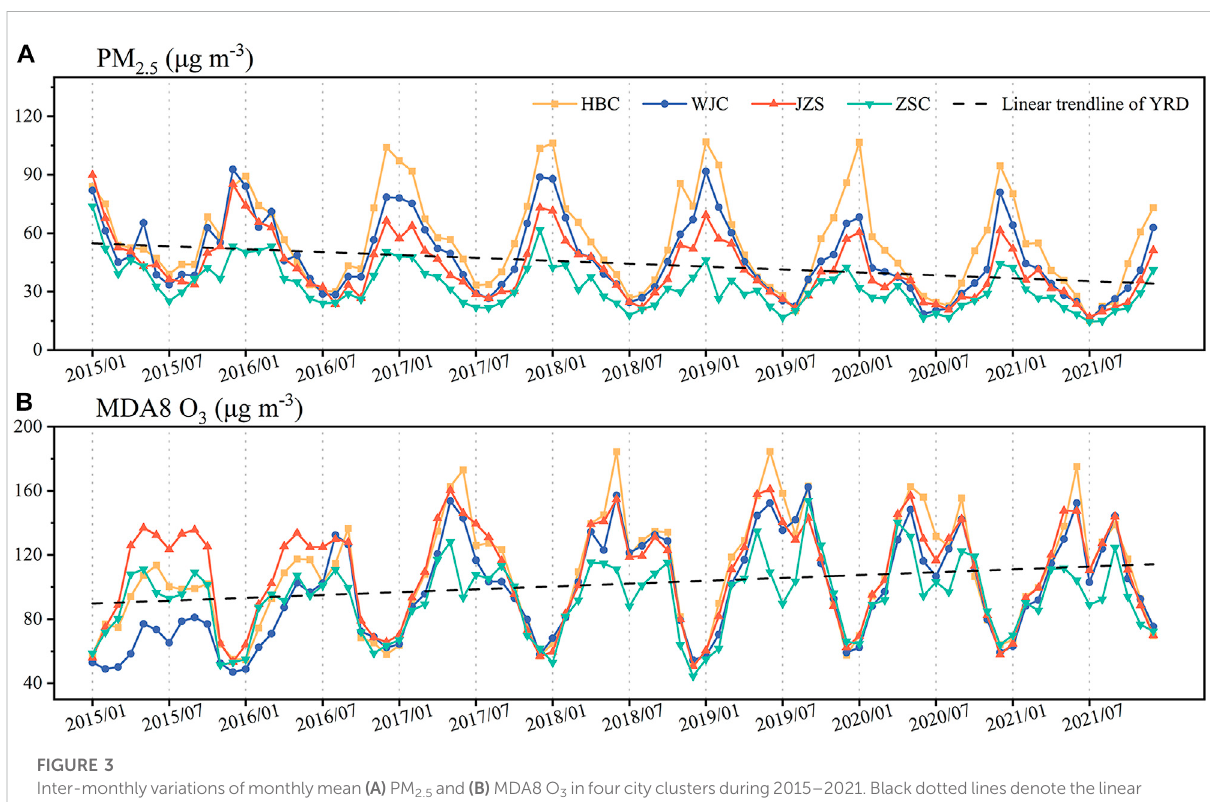
FIGURE 3 Inter-monthlyvariationsofmonthlymean (A) PM 2.5 and (B) MDA8O 3 infourcityclustersduring2015 – 2021.Blackdottedlinesdenotethelinear trendlines of the whole